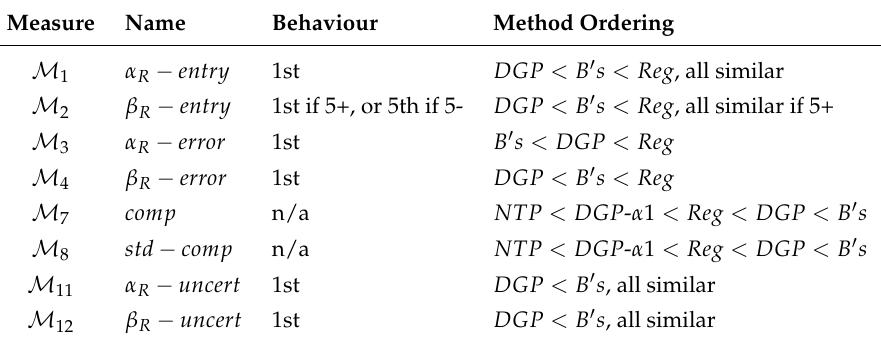
Table 11. Selection of methods for the CRUMB robot